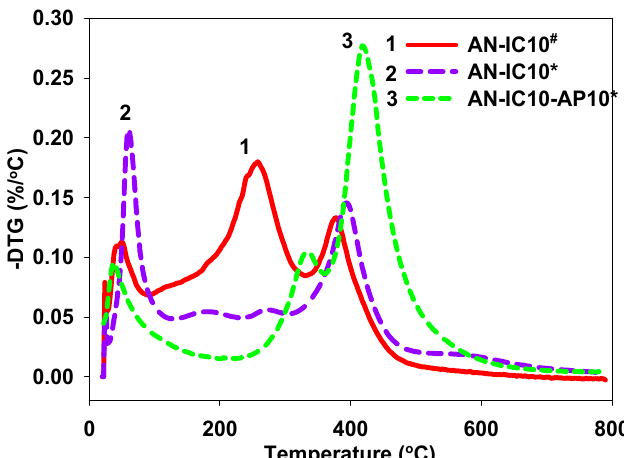
Figure 1. DTG profiles of the as-synthesized ( # ) alumina–silica composite with isocyanurate bridging groups and alumina–silica composites with isocyanurate bridging groups in the presence and absence of aminopropyl groups after extraction followed by calcination (*). Note: AN and AP refer to the aluminum nitrate and aminopropyl, respectively.